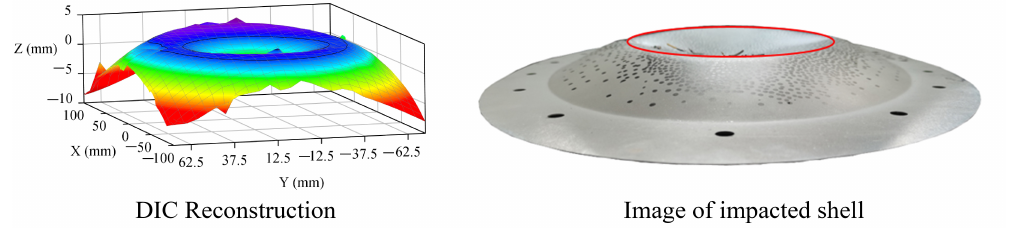
Figure 7. Boundary shape of the depressed deformation.